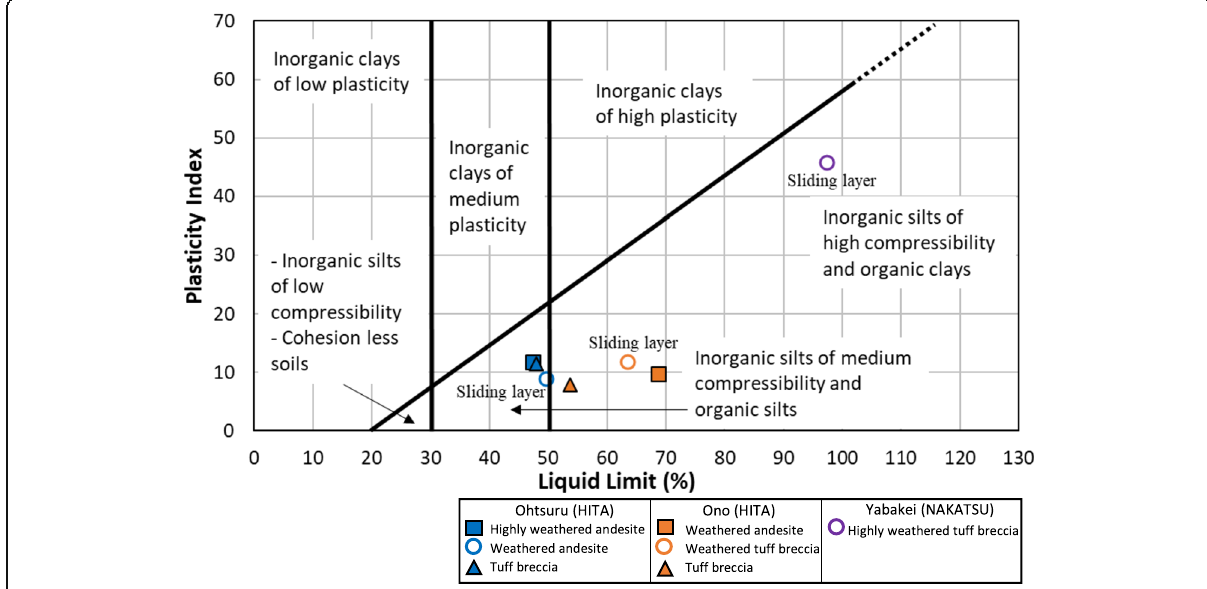
Fig. 11 Plotted data of soil materials on plasticity